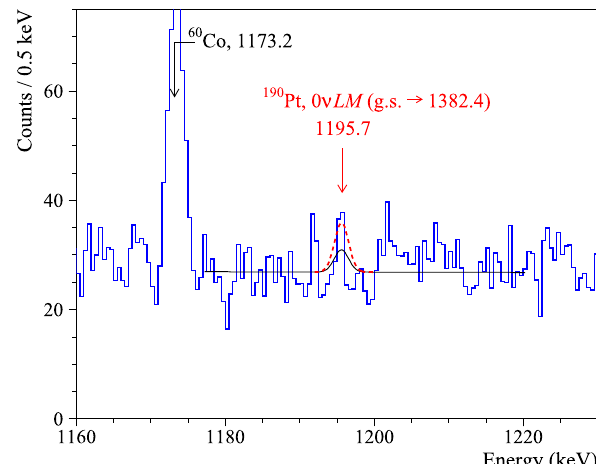
Fig. 9 The energy spectrum in the vicinity of γ peak 1195.7 keV expected in the near resonant 0 ν LM transition of 190 Pt to the ( 0 , 1 , 2 ) + 1382.4 keV level of 190 Os. The fit of the data is shown by solid line, while the excluded peaks are presented by dashed line